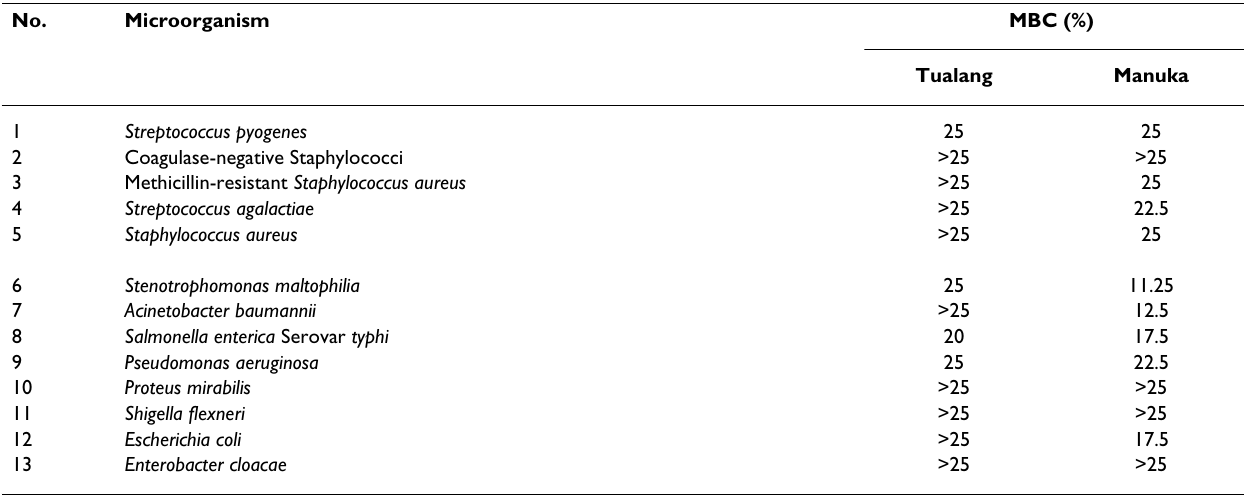
Table 2: MBC values (%) of tualang honey and manuka honey